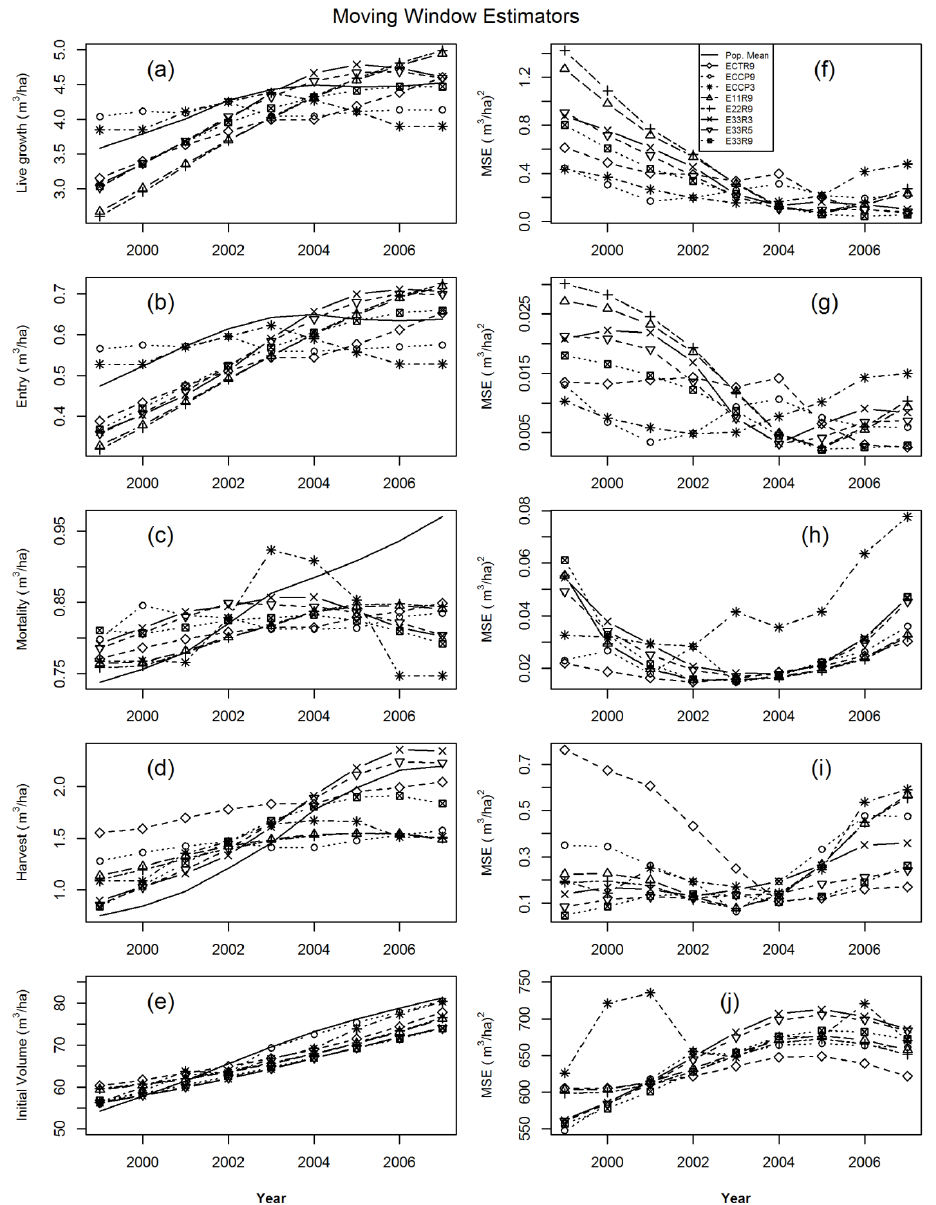
Figure 2. The empirical means of the moving window annual estimators (ECTR9, ECCP9, ECCP3, E11R9, E22R9, E33R3, E33R5 and E33R9) plotted with the true population mean for ( a ) live growth; ( b ) entry; ( c ) mortality; ( d ) harvest; and ( e ) initial volume; and the corresponding mean squared errors for ( f ) live growth; ( g ) entry; ( h ) mortality; ( i ) harvest and ( j ) initial volume, from the simulation of 1000 iterations of 1000 samples each under Sample Error Structure